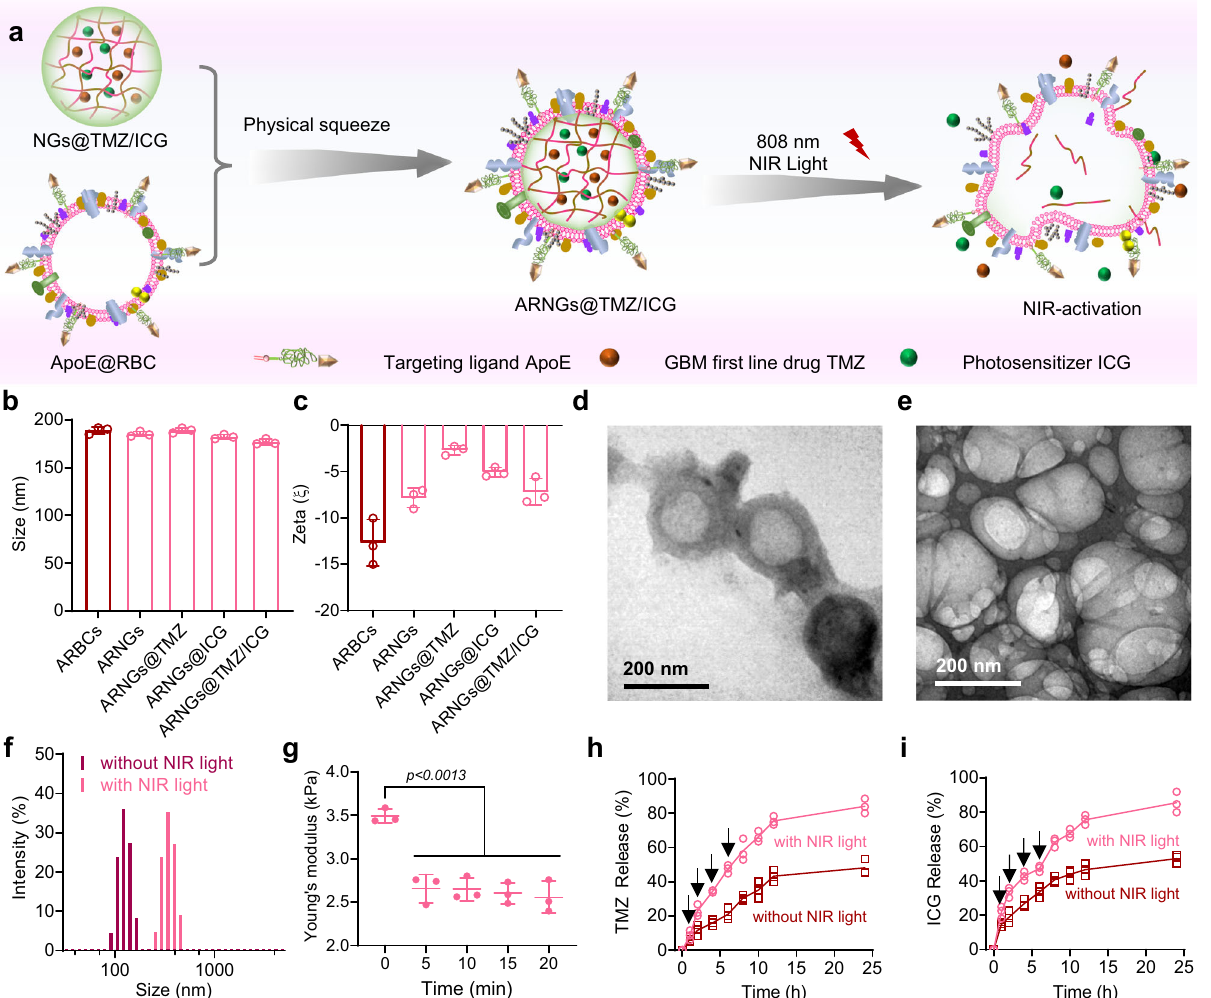
Fig. 3 | Preparation of ARNGs@TMZ/ICG and NIR-induced deformation. a Schematic illustration of camou fl aging ARNGs@TMZ/ICG by ApoE peptide- decorated erythrocyte membranes and NIR-induced deformation of the nanogels. b , c Sizedistribution( b )andzetapotential( c )ofvariousnanoparticlesmeasuredby DLS (n=3 independent experiments). Data are presented as mean±SD d , e TEM images of ARNGs@TMZ/ICG before ( d ) and after ( e ) NIR irradiation (808nm, 0.5Wcm − 2 ,5min). f ParticlesizedistributionofARNGs@TMZ/ICGwithandwithout